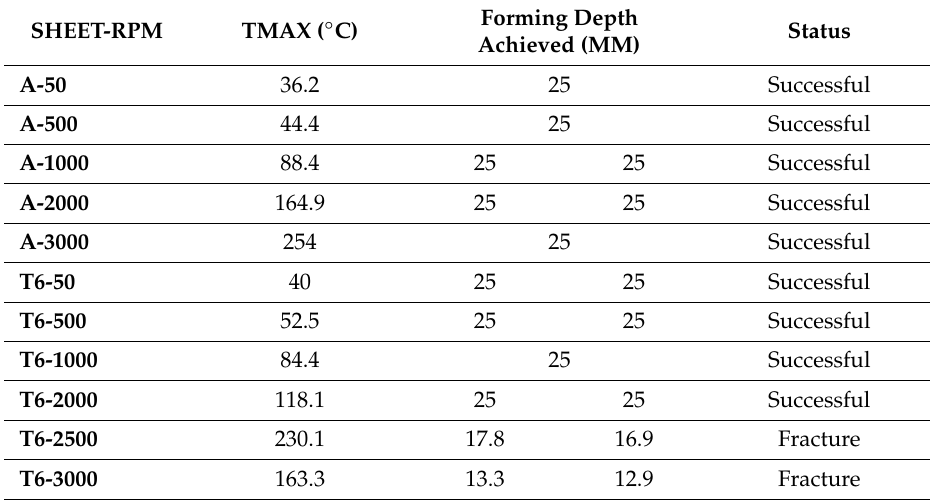
Table 2. Success status of T6 and annealed parts: height = 25 mm, forming angle = 45 ◦ and tool diameter = 12